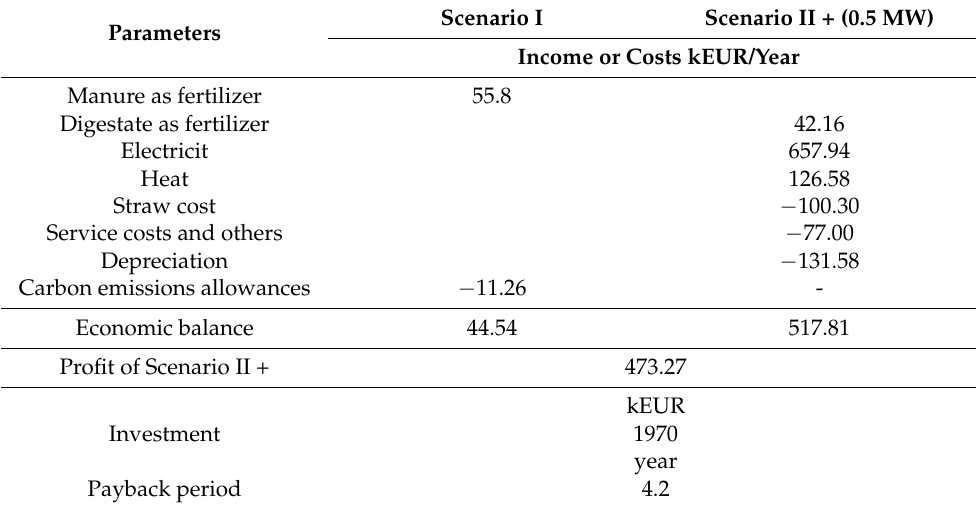
Table 10. Economic balance for manure management with and without biogas